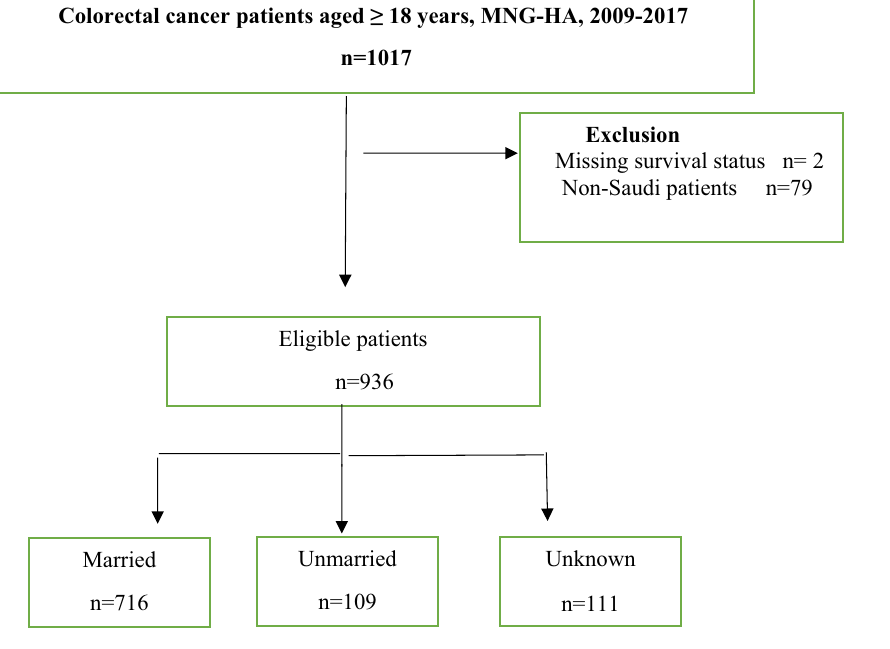
Figure 1. Eligibility criteria for the study